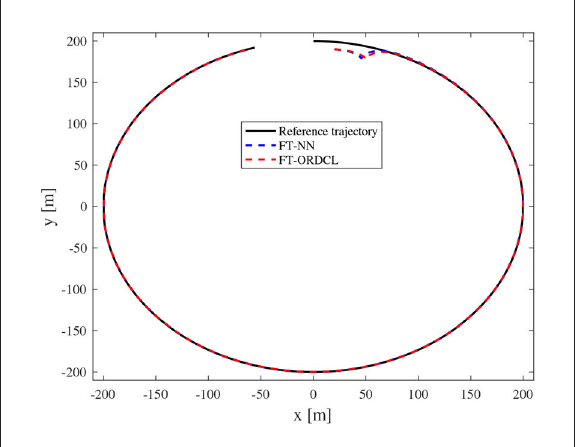
FIGURE1 Reference and actual trajectories of the MSV in Case